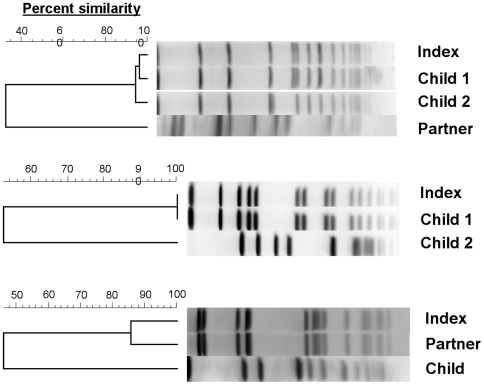
Dendrogram of isolates from three different households illustrating the presence of both similar and dissimilar isolates.Isolates >70% similar are considered closely related.